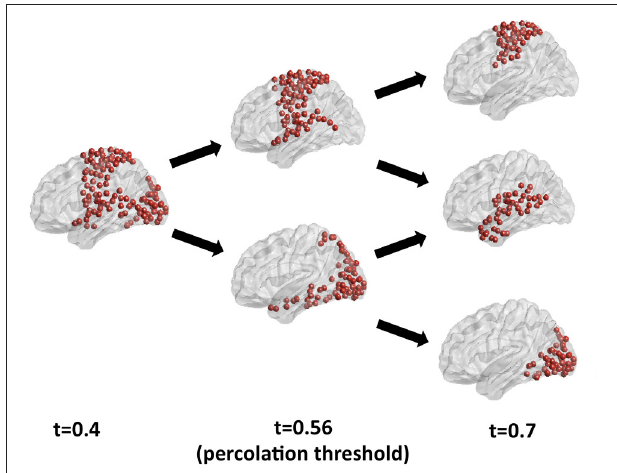
FIGURE 8 | Analysis of the largest modules detected by Newman’s community detection algorithm in a resting state functional connectivity network from the human brain for different thresholds. At percolation threshold (central panel) the sensorimotor and the visual modules are identified as separate communities, while they are merged into a widespread subnetwork for a threshold below percolation. For a higher threshold (right panel) fragmentation and reorganization of modules is apparent, with the emergence of a separate temporal module, and a break-up of dorsal sensorimotor and supramarginal and temporal